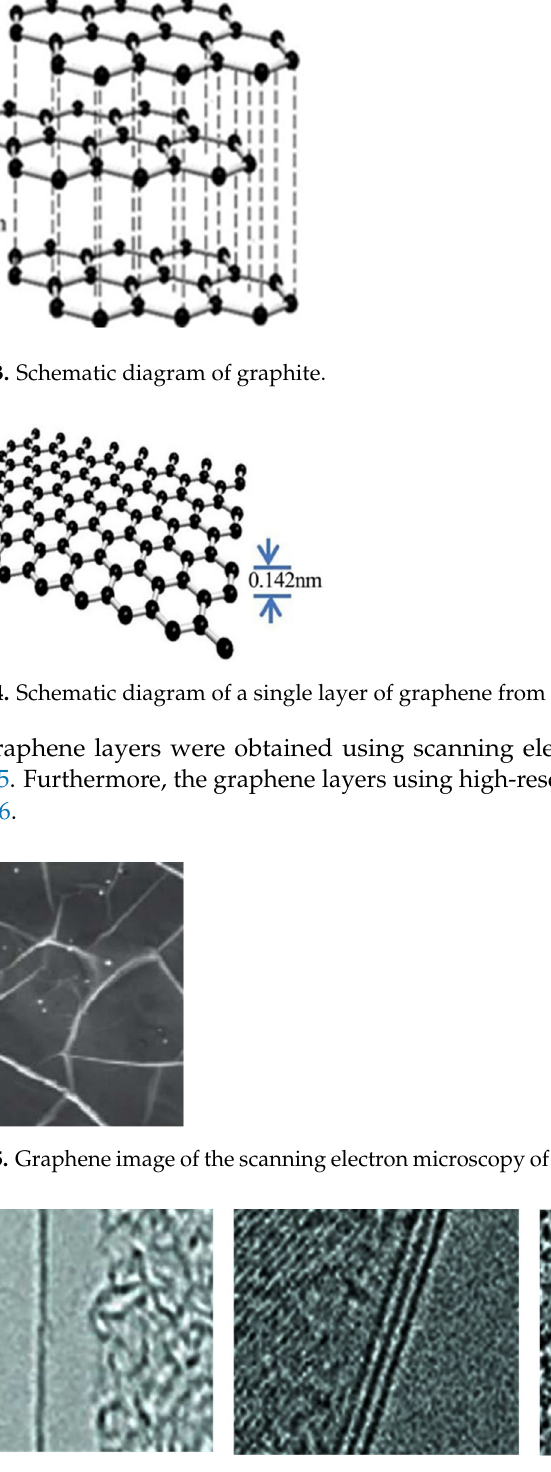
Figure 6. High ‐ resolution transmission electron microscope image. Figure 6. High-resolution transmission electron microscope